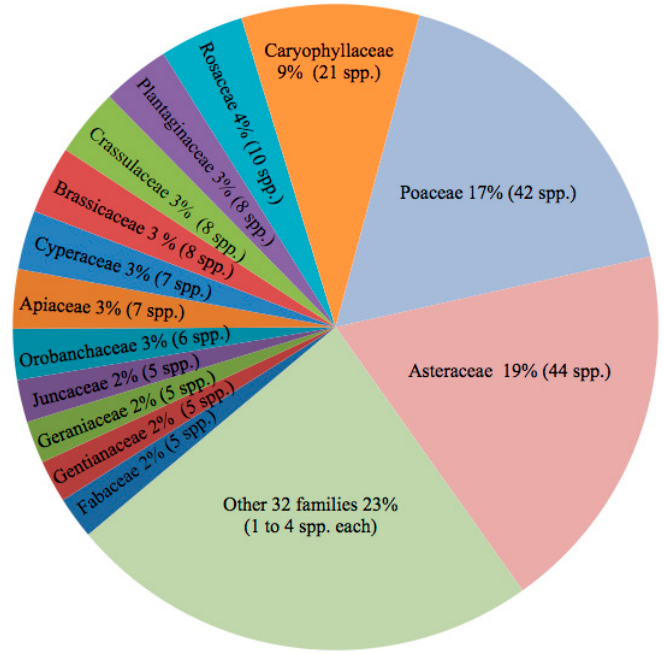
Figure 4. Family-level composition of the vascular flora of central Mexico.